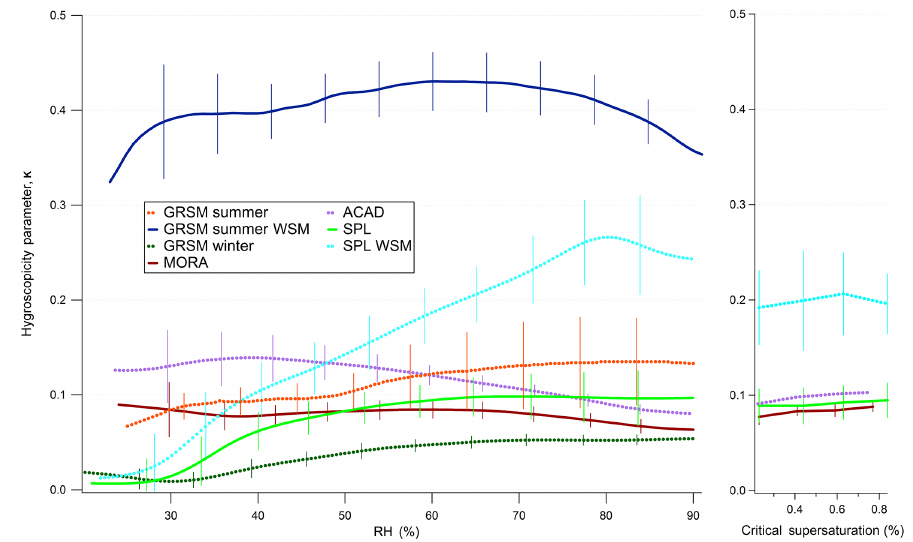
Figure 3. Average κ (RH) and κ (SS C ) from all initially hydrated hygroscopicity measurements for all WSOC and WSM samples. Whiskers indicate the standard deviation between samples from each